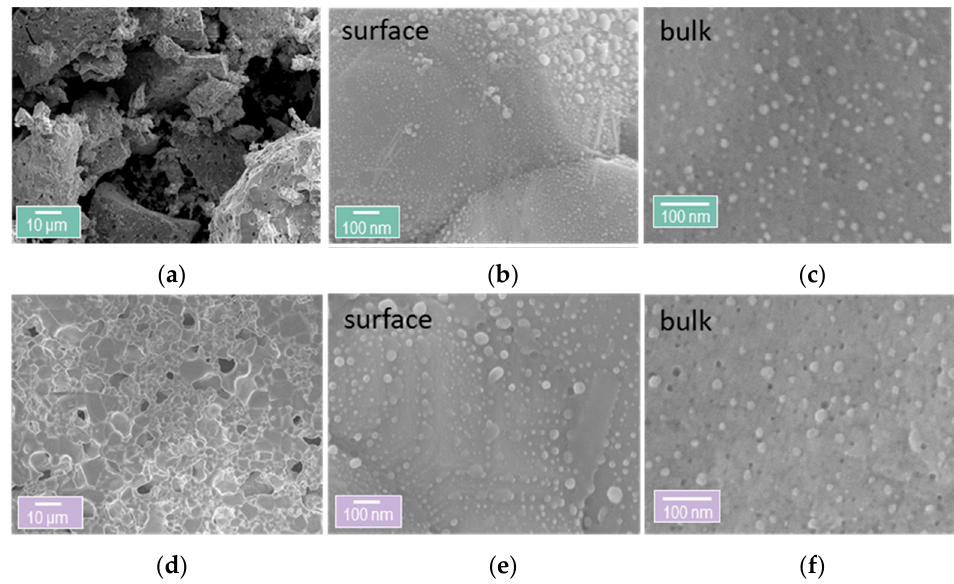
Figure 8. Micro- and nanostructure of the Rh infiltrated exsolved perovskites. ( a ) Overview of the microstructure of the infiltrated coarse powder Rh|cP-Ni. ( b ) Nanostructure of the surface of Rh|cP-Ni. ( c ) Nanostructure of the bulk of Rh|cP-Ni. ( d ) Overview of the microstructure of the infiltrated pellet Rh|pP-Ni. ( e ) Nanostructure of the surface of Rh|pP-Ni. ( f ) Nanostructure of the bulk of Rh|pP-Ni.